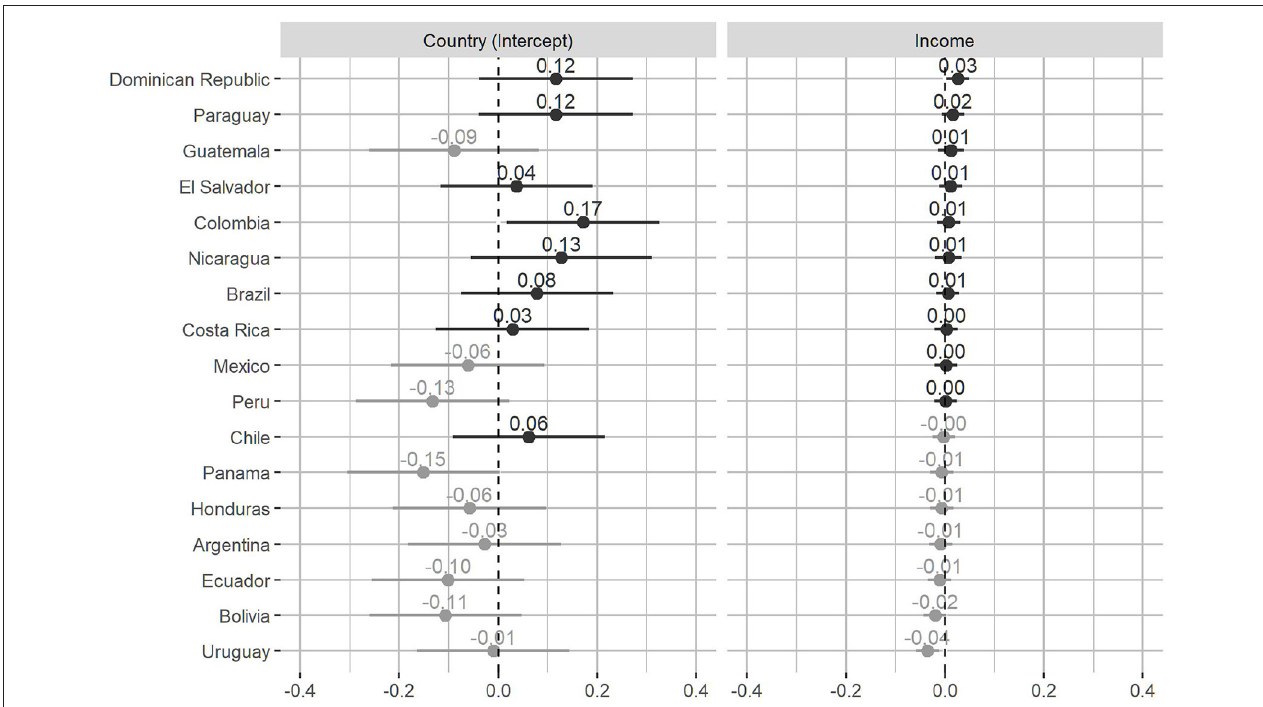
FIGURE 6 | Income random effect on support for redistribution by country: intercept and slope. Points show predicted coefficients; bars represent 95% confidence